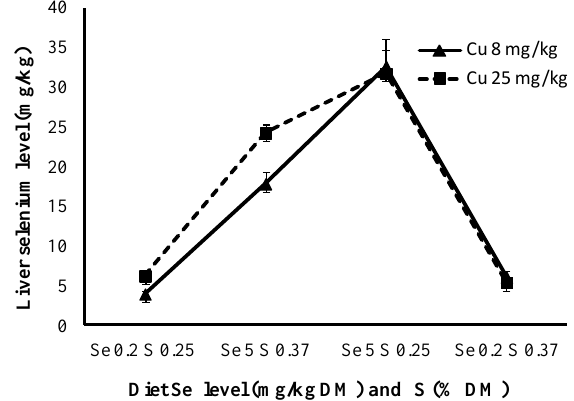
Figure 2. Liver selenium concentration of lambs with different levels of selenium and sulphur in the diet.